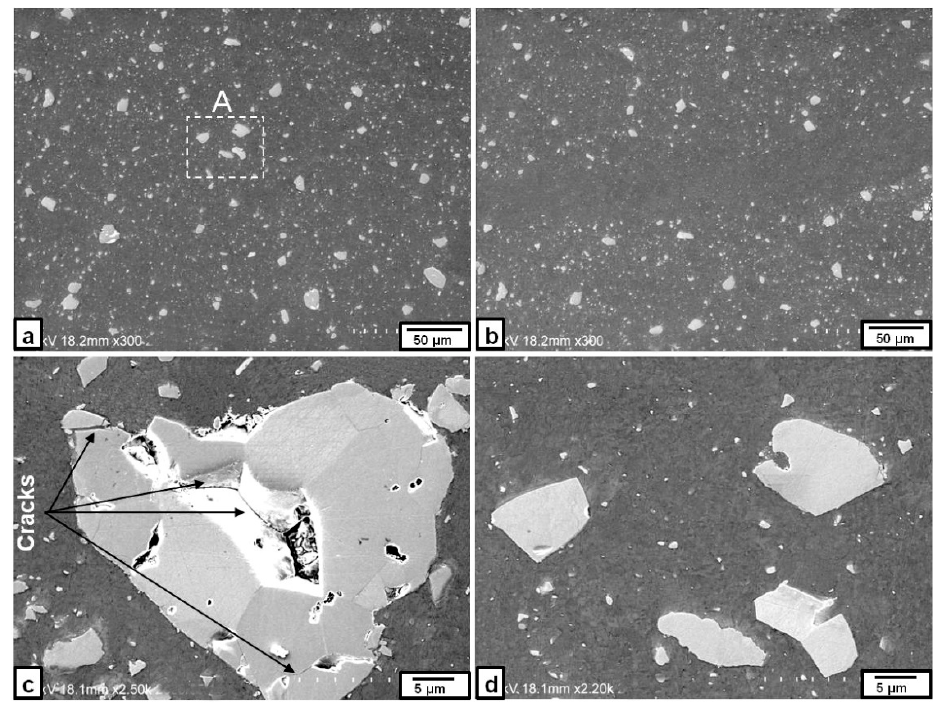
Figure 9. SEM images of the Fe 3 O 4 particles dispersed in the nugget zone produced by triple FSP passes at a rotation speed of 1500 rpm: ( a ) central area; ( b ) banded structure in the center; ( c ) large Fe 3 O 4 particle involving cracks; and ( d ) magnified image of area A in ( a ).